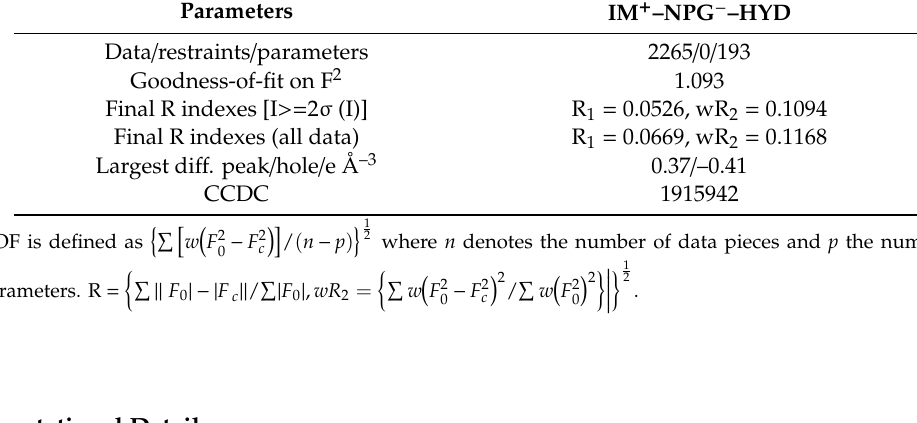
Figure S1: IR spectra of solid polycrystalline samples of imidazole (Purple), NPG (Blue) and IM + –NPG − –HYD (Red); Figure S2: DFT / M062X / 6-31G** simulated IR spectrum of IM + –NPG − –HYD ; Figure S3: ESI-MS spectrum of polycrystalline samples of IM + –NPG − –HYD ; Figure S4: Diagram illustrating the packing of IM + –NPG − –HYD in the unit cell at 100 K (H atoms have been omitted for clarity); Figure S5: DFT optimized structures in EtOH of both the configuration (a) A and (b) B of the IM + –NPG − –HYD at the M062X / 6-31G** level of theory. Bond distances given in angstrom (Å); Figure S6: Hirshfeld surface mapped with dnorm (left), shape index (middle), and curvedness (right) for the IM + –NPG − –HYD ; Figure S7: QTAIM analysis of N ··· C, and O ··· O interactions in IM + –NPG − –HYD (configuration A ): (a) contour line plots of the electron density ρ , (b) contour line plots of the Laplacian distribution of electron density ∇ 2 ρ (r), the solid (red) and dashed (blue) lines corresponds to positive and negative values of ∇ 2 ρ (r) respectively, (c) surface maps of electron localization function (ELF), and (d) NCI surface between IM + and NPG − showing electron density for π - π stacking interaction. Bond paths are shown as black lines, selected zero-flux surfaces, bond critical points, and BCPs, (3, − 1) are shown in blue; Figure S8: Showing charge transfer donor-acceptor moieties of both the configuration (a) A and (b) B of the IM + –NPG − –HYD . Pink arrow represents the dipole moment vector; Figure S9: Electron (green isosurface) and hole (blue isosurface) distribution between excited state and ground state of IM + –NPG − –HYD for the absorptions at 297, 336, 427, and 443 nm. Value of contour envelopes is 0.002 au; Figure S10: Electron (green isosurface) and hole (blue isosurface) distribution between excited state and ground state of IM + –NPG − –HYD for the absorptions at 510, 530, 427,